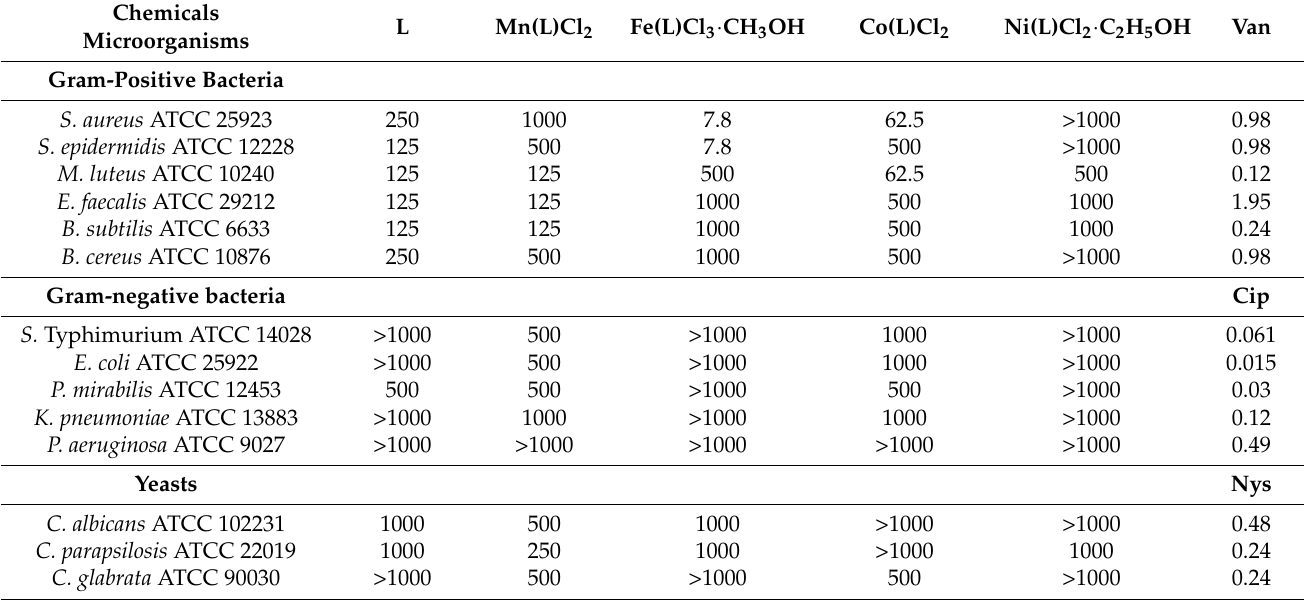
We screened the free ligand and its four complexes for activity against Gram-positive and Gram-negative bacteria, as well as against yeasts. Vancomycin (Van), ciprofloxacin (Cip), and nystatin (Nys) were used as the standard drugs (Table 4). Table 4. Activity of the tested compounds against bacteria and yeasts presented as minimal inhibitory concentration values (mg/L).